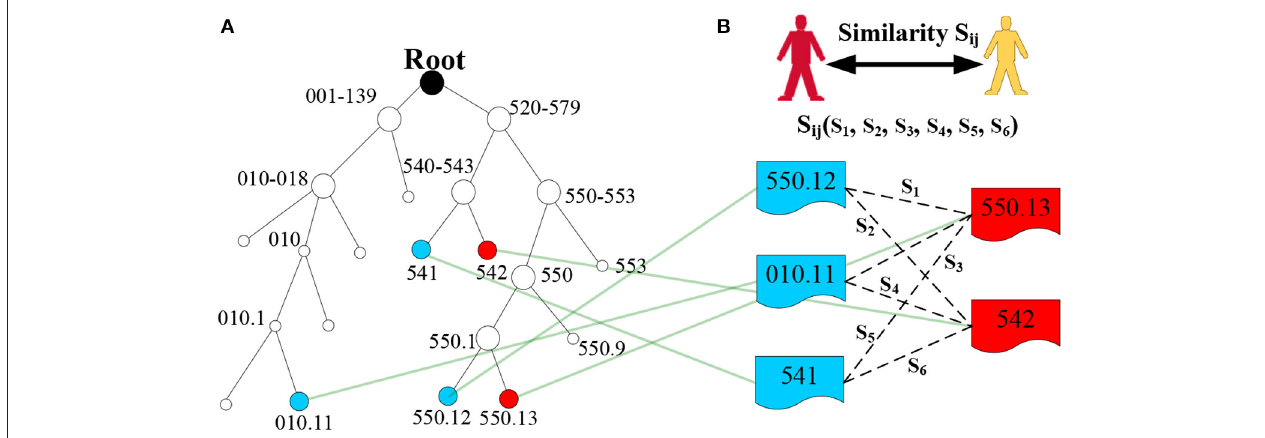
FIGURE 4 | Example of LCA generation in the ICD-9 ontology structure. (A) Denotes the ICD-9 ontology structure, and (B) denotes the diagnosis codes of two patients.